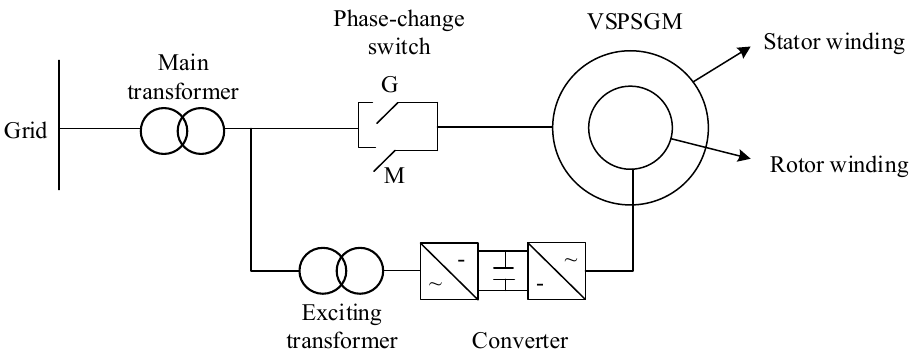
Figure 1. Schematic diagram of VSPSGM connected to the power grid .